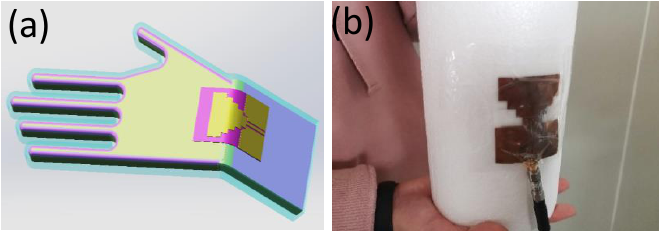
Figure 8. ( a ) Conformal diagram of radial wrist joint and antenna ( b ) Conformal test of antenna .